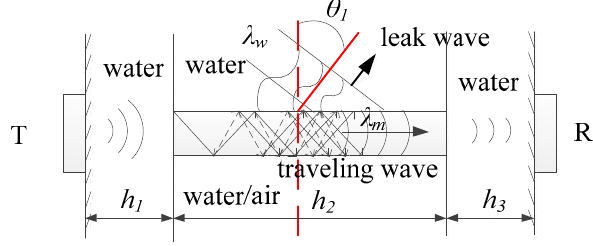
Figure 3. The principle of inspection.